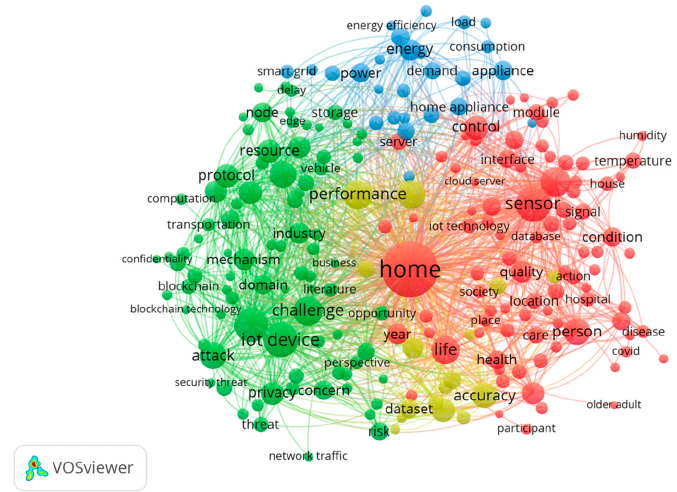
Figure 9. Analysis of the co-occurrences in titles and abstracts.